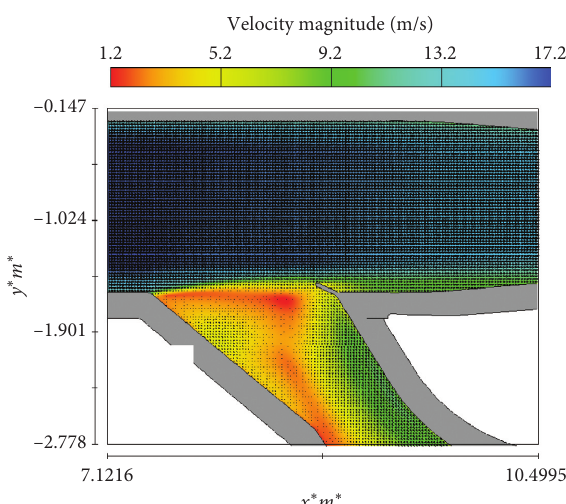
Figure 17: Velocity change’s size and vectors in the branch area at 100% gate and valve